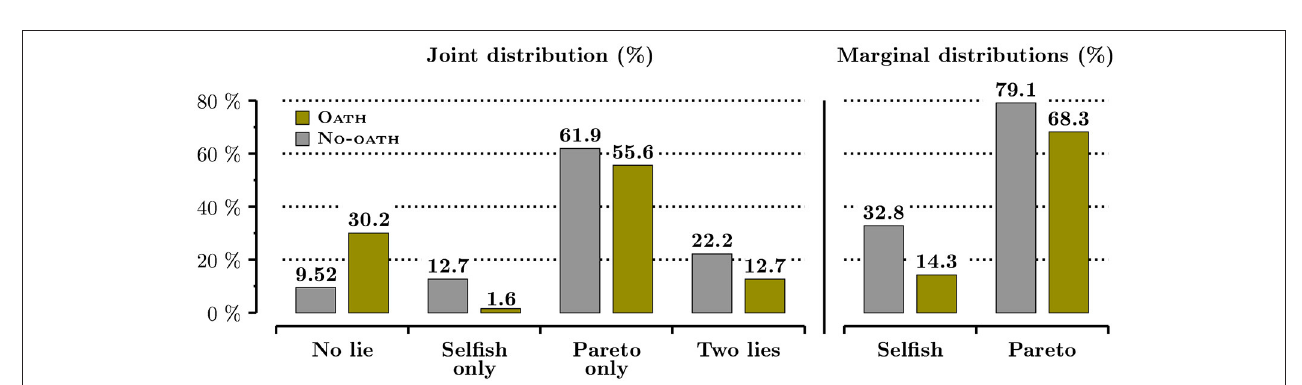
FIGURE 2 | Distributions of lies in the sender-receiver game in the NO-OATH conditions.